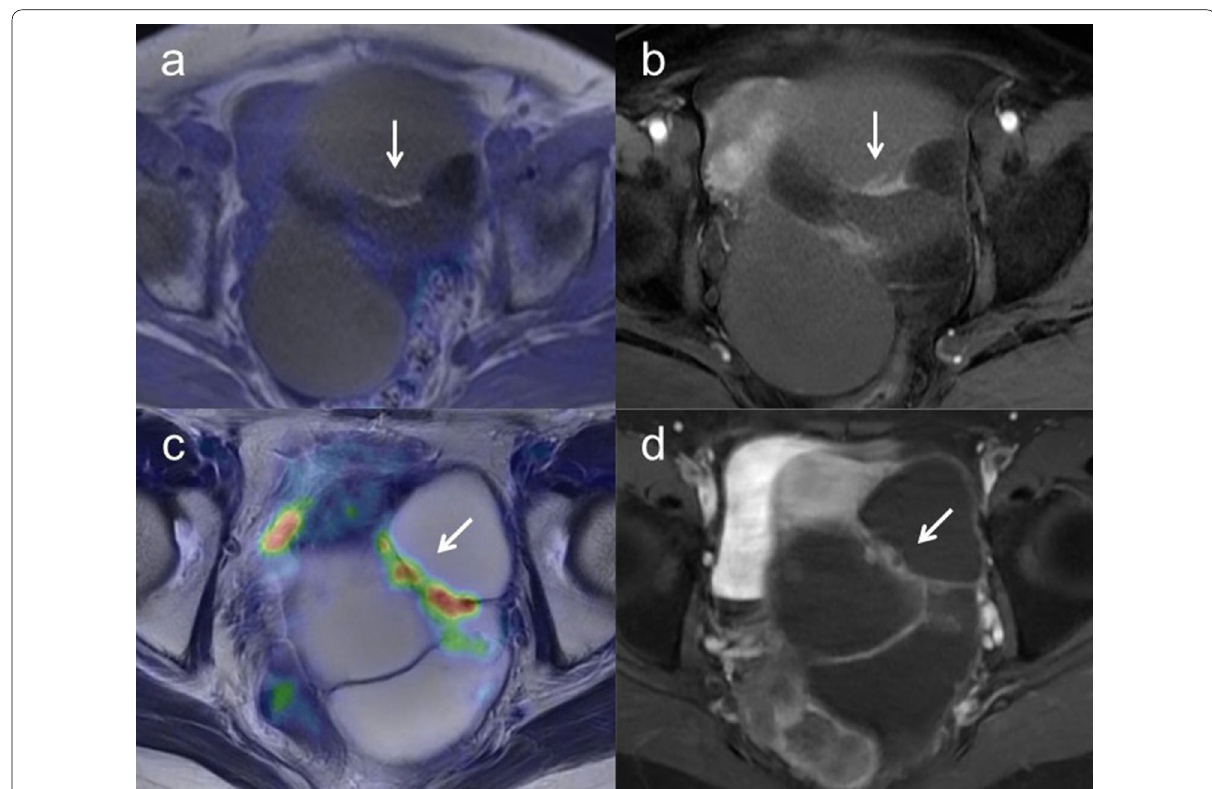
Fig. 1 a A 57-year-old woman with left ovarian tumor. Axial T2-weighted PET/MR image shows wall thickening without FDG uptake (arrow) in the polycystic left ovarian tumor. b Axial T1-weighted contrast-enhanced MR image shows wall thickening with good enhancement (arrow), suggesting the possibility of malignancy. However, histopathologic examination confirmed mucinous cystadenoma without malignancy. c A 53-year-old woman with left ovarian tumor. Axial T2-weighted PET/MR image shows wall thickening with FDG uptake (arrow) in the polycystic left ovarian tumor. d Axial T1-weighted contrast-enhanced MR image shows wall thickening with good enhancement (arrow). These findings strongly suggest potential malignancy and histopathologic examination confirmed seromucinous borderline